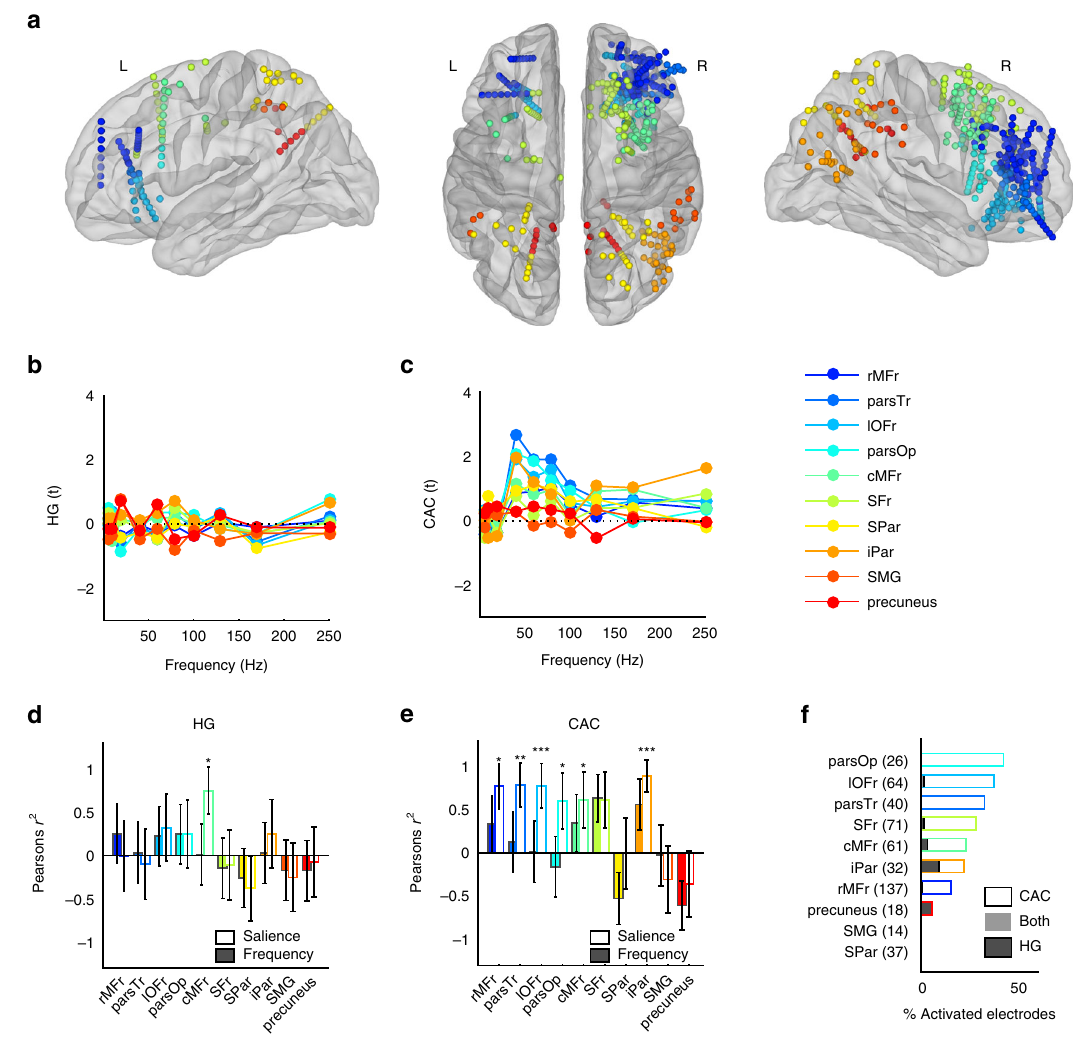
Fig. 5 HG and CAC response patterns in frontal and parietal sub-regions. a Anatomical and functional categorisation of electrodes in frontal and parietal lobes, based on the Desikan-Killiani anatomical parcellation. b HG responses (expressed in t -values relative to the baseline) averaged within regions and across participants at each stimulus frequency. c Same as in ( b ) for CAC. d Pearson ’ s correlation value ( r 2 ) between onset HG responses and stimulus frequency (colour- fi lled bars) and salience (empty bars). Error bars indicate SE of the correlation. e Same as in ( d ) for CAC. f Proportion of activated electrodes exhibiting signi fi cant HG onset response (dark shading), sustained CAC (no shading) or both (grey shading) in each network. Numbers on the y-axis indicate the number of electrodes located in each region. *, ** indicate signi fi cant (corrected) p -values at 0.05, 0.01, respectively. rMFr rostral Middle Frontal, parsTr Pars Triangularis, iOFr inferior Orbito-Frontal, parsOp Pars Opercularis, cMFr Caudal Middle Frontal, SFr Superior Frontal, SPar Superior Parietal, iPar inferior Parietal, SMG Supra-Marginal pro fi les signi fi cantly correlated with the aversion pattern (Fig. 6e). Comparing the proportion of electrodes showing reliable HG or